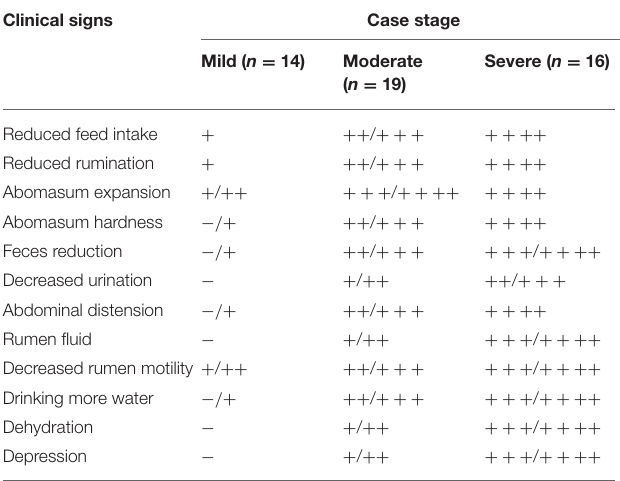
TABLE 1 | Clinical data from 49 AI cases in beef